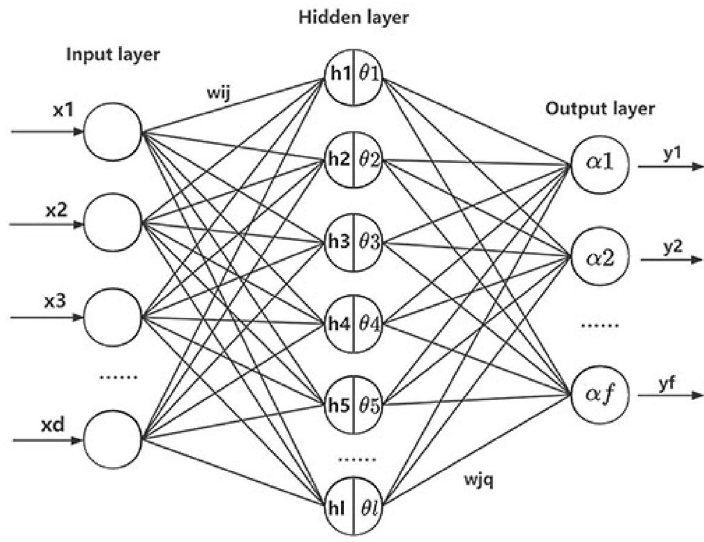
Figure 2. Basic structure diagram of BP neural network.